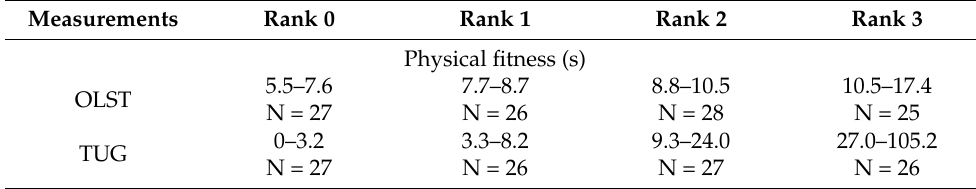
Table 3. Quartile cutoff values for various physical fitness and oral functional status measurements at baseline (Min.-Max, N: number of participants).